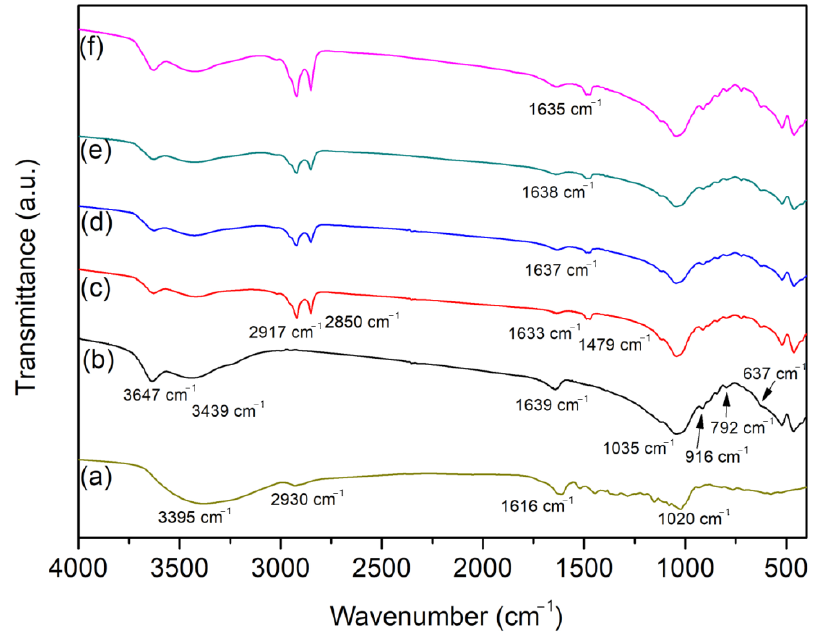
Figure 2. FTIR spectra of ACN ( a ), Bent ( b ), CTAB-Bent ( c ), CTAB/ACS/Bent-4 ( d ), CTAB/ACS/Bent-7 ( e ), and CTAB/ACS/Bent-10 ( f ).